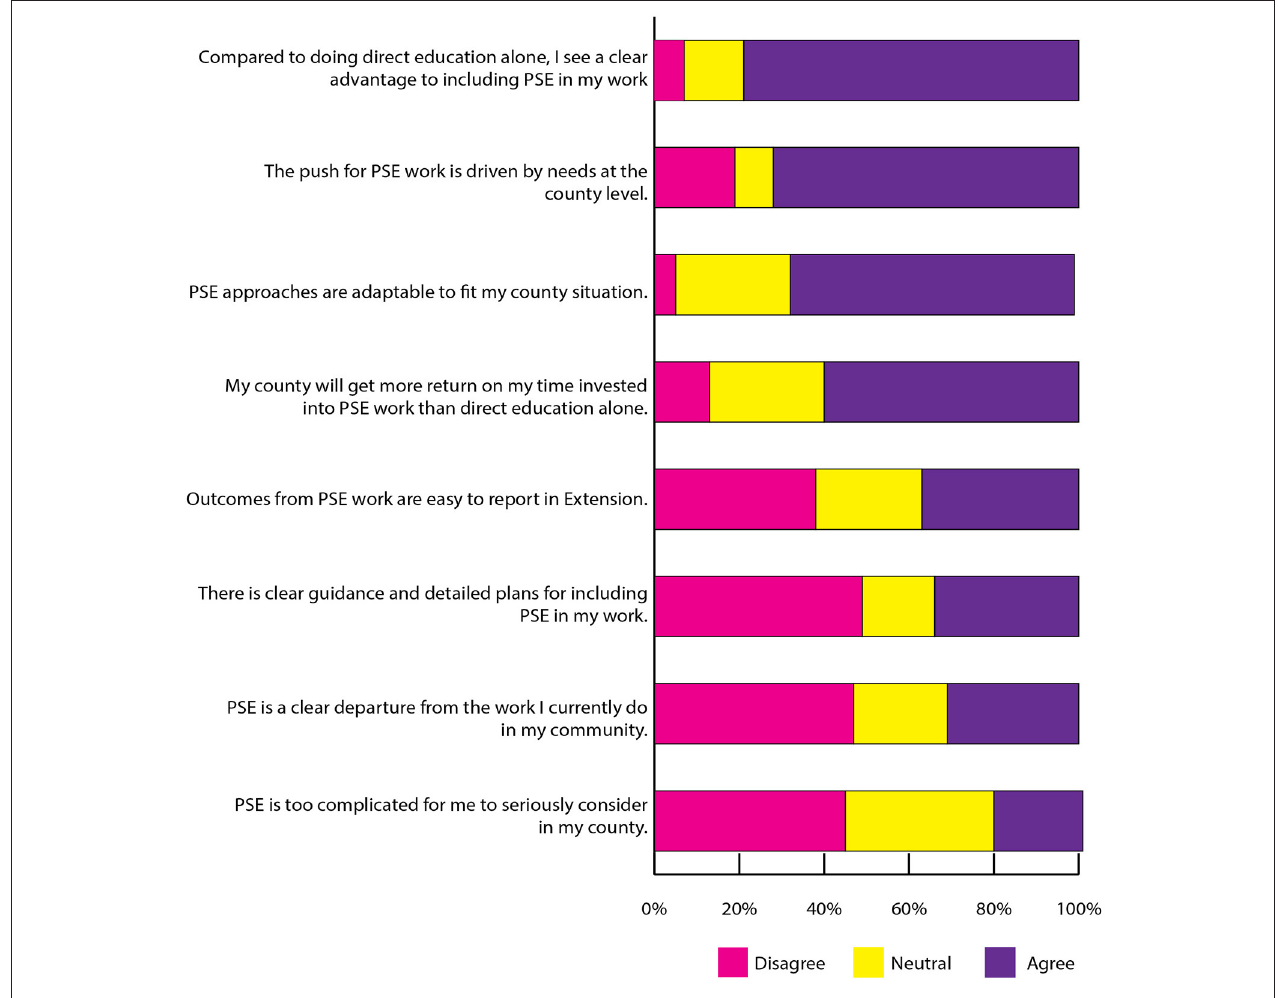
FIGURE 1 | Intervention